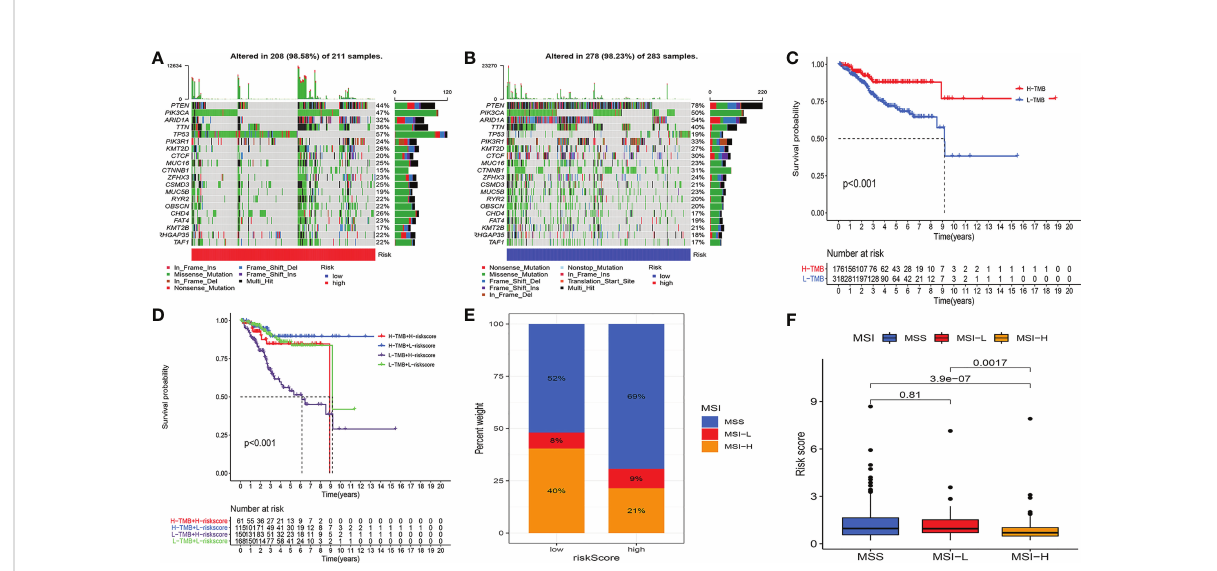
FIGURE 7 Multi-omics analysis of the model. (A, B) Gene mutation frequencies in both groups. (C, D) Survival analysis. H-TMB has a better prognosis. (E, F) MSI analysis. The low MSI accounted for the least, and the high MSI group had the lowest risk